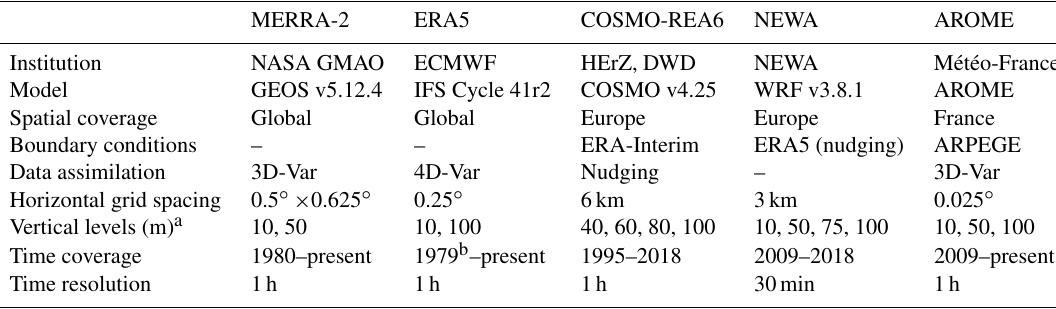
Table 1. Information on the numerical datasets evaluated in the study.